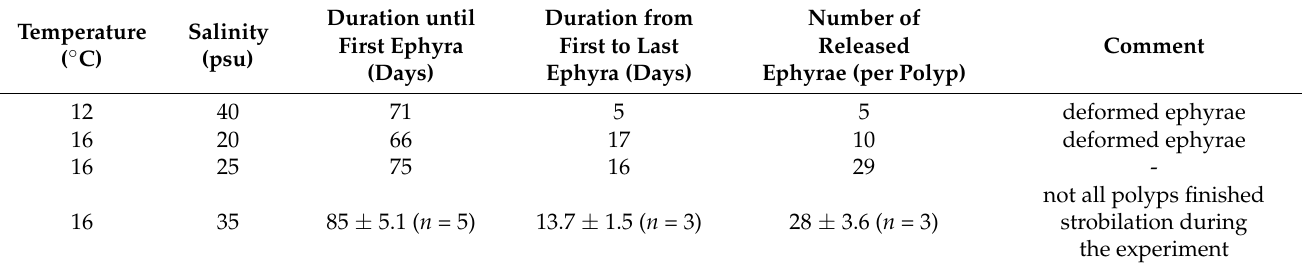
Table 2. Data shows combinations of temperatures and salinities that resulted in strobilation in Aurelia solida polyps, including durations until the first and last ephyra were released, the number of released ephyrae per polyp, and comments on the state of released